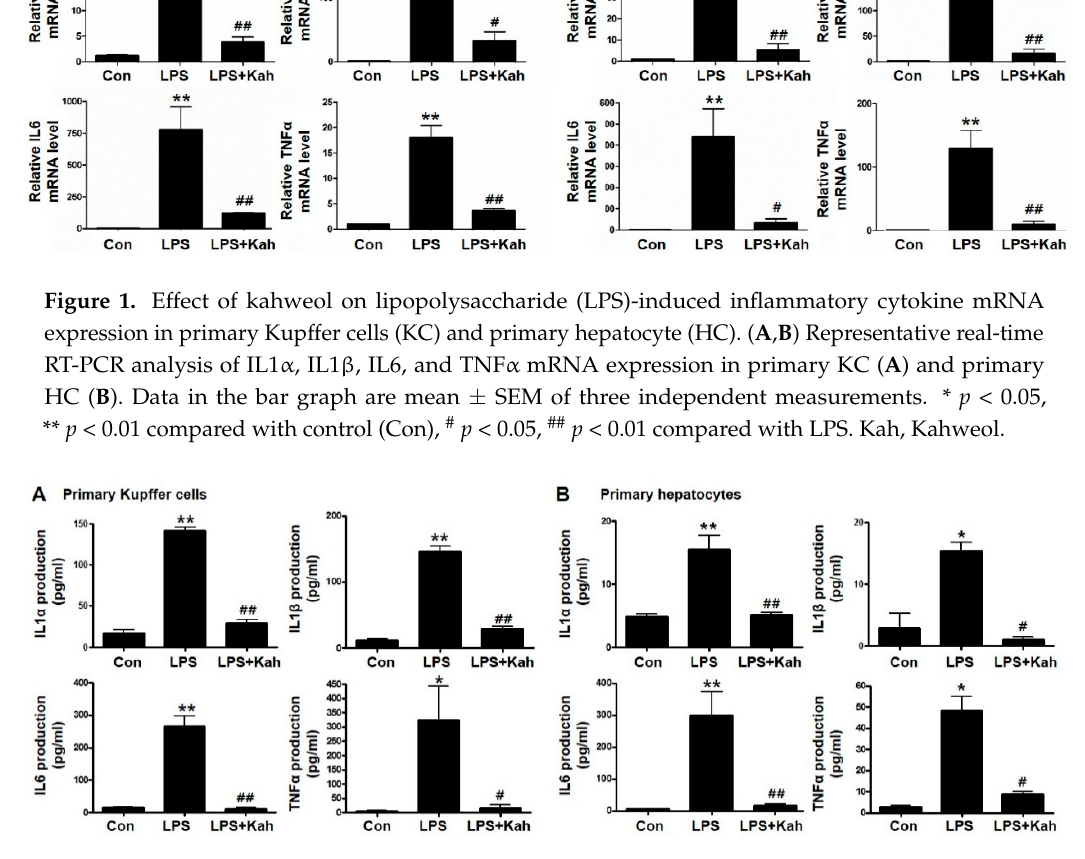
Figure 2. Effect of kahweol on lipopolysaccharide (LPS)-induced production of IL1 α , IL1 β , IL6, and TNF α . Primary Kupffer cell (KC) (A) and primary hepatocyte (HC) (B) media were collected after LPS and kahweol (kah) treatment, the production of IL1 α , IL1 β , IL6, and TNF α were measured using the ELISA kits. Data in the bar graph are mean ± SEM of three independent measurements. * p < 0.05, ** p < 0.01 compared with control (Con), # p < 0.05, ## p < 0.01 compared with LPS. Kah, Kahweol